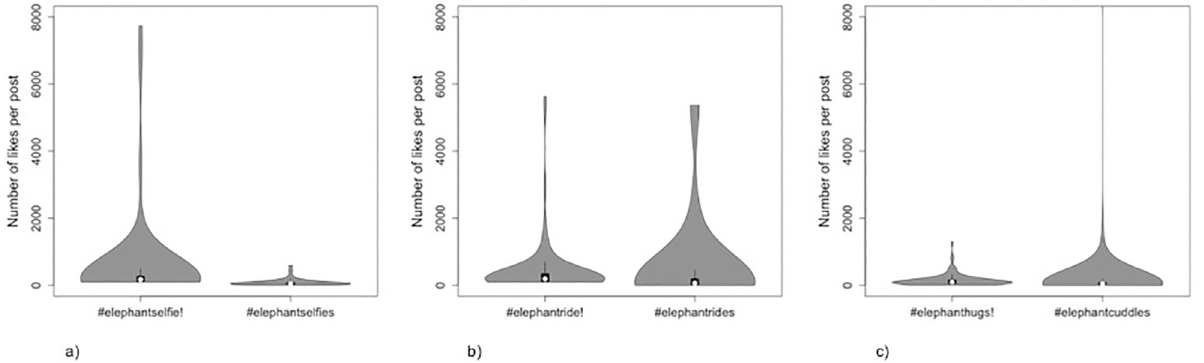
Fig 4. Violin plots showing popularity (as measured by number of likes) of elephant selfie posts using each of six hashtags, where the first of each pair of terms—a). #elephantselfie and #elephantselfies, b). #elephantride and #elephantrides, c). #elephanthugs and #elephantcuddles—triggers Instagram’s warning (marked by an!) and the second does not. Circles depict the median (RCV Q = 0.64, 0.88, 0.86, 1.94, 0.91, 0.97, respectively); maximum value for #elephantselfie not shown to improve visual comparison.